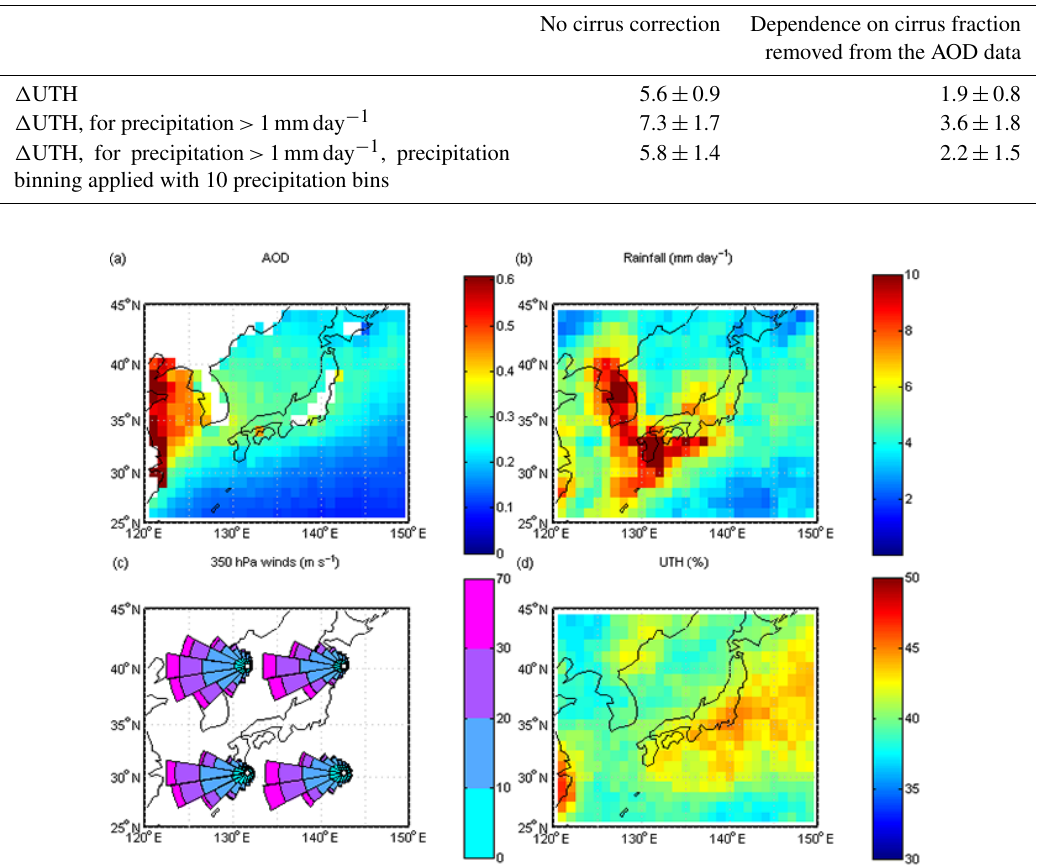
Figure 5. The study region and the data used. (a) AOD, (b) daily precipitation, (c) 350hPa wind roses and (d) UTH in the study region east of China averaged from the observations in June, July and August in 2007–2013. (a) Aerosol outflow from continental China clearly dominates AOD in the region, with contributions from Japan and Korea. (b) Precipitation is plentiful in the region. (c) Mean wind direction in the region is westerly. (d) There are high UTH values downwind of the regions with large values of precipitation.